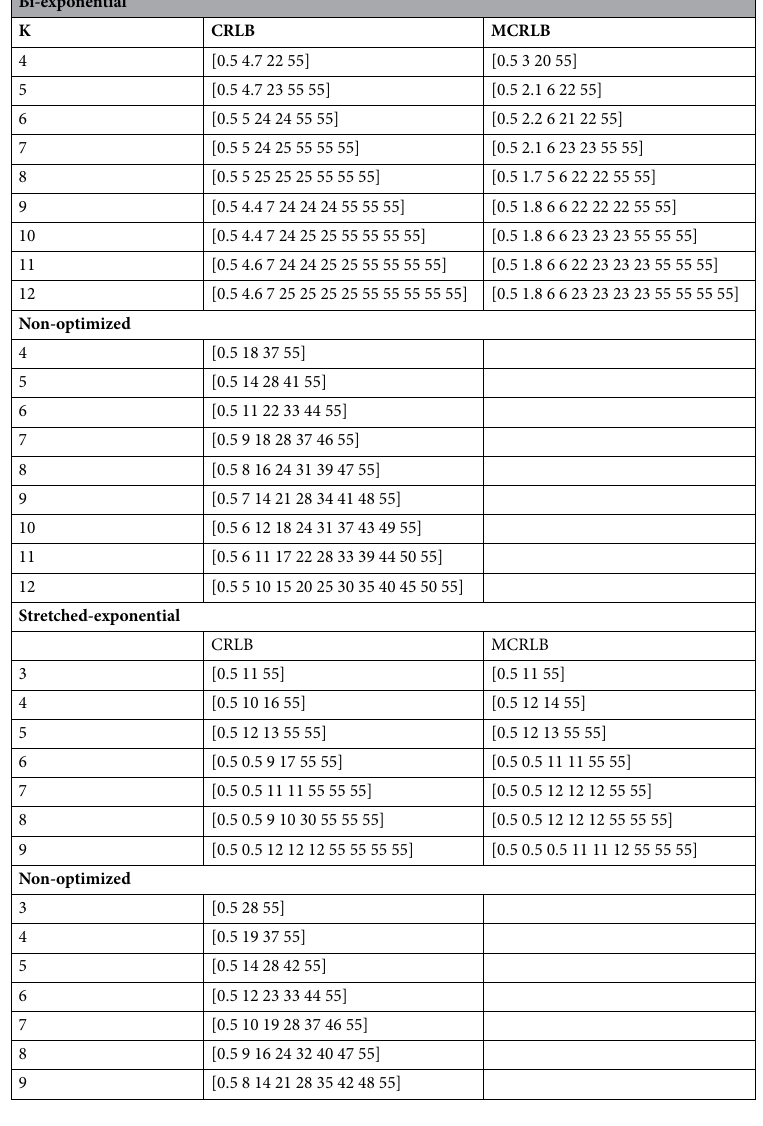
Table 2. Optimized and non-optimized sampling schedules for both multi-exponential